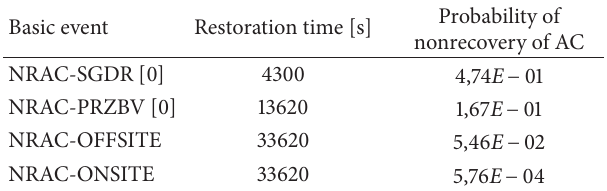
Table 1: Probability of nonrecovery of AC power within given time.